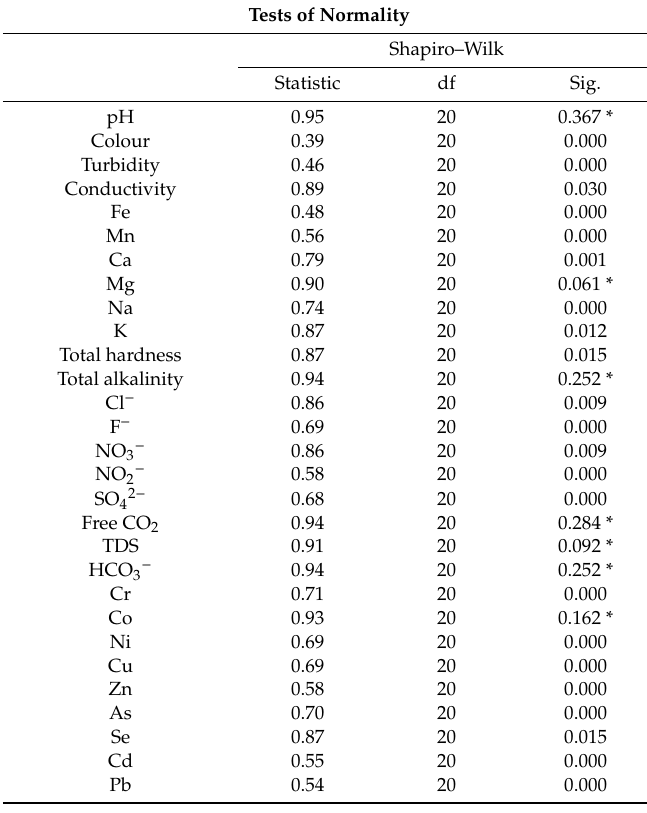
Table 2. Results of normality test of data for di ff erent water quality parameters. The variables with asterisks show normal distribution ( p >